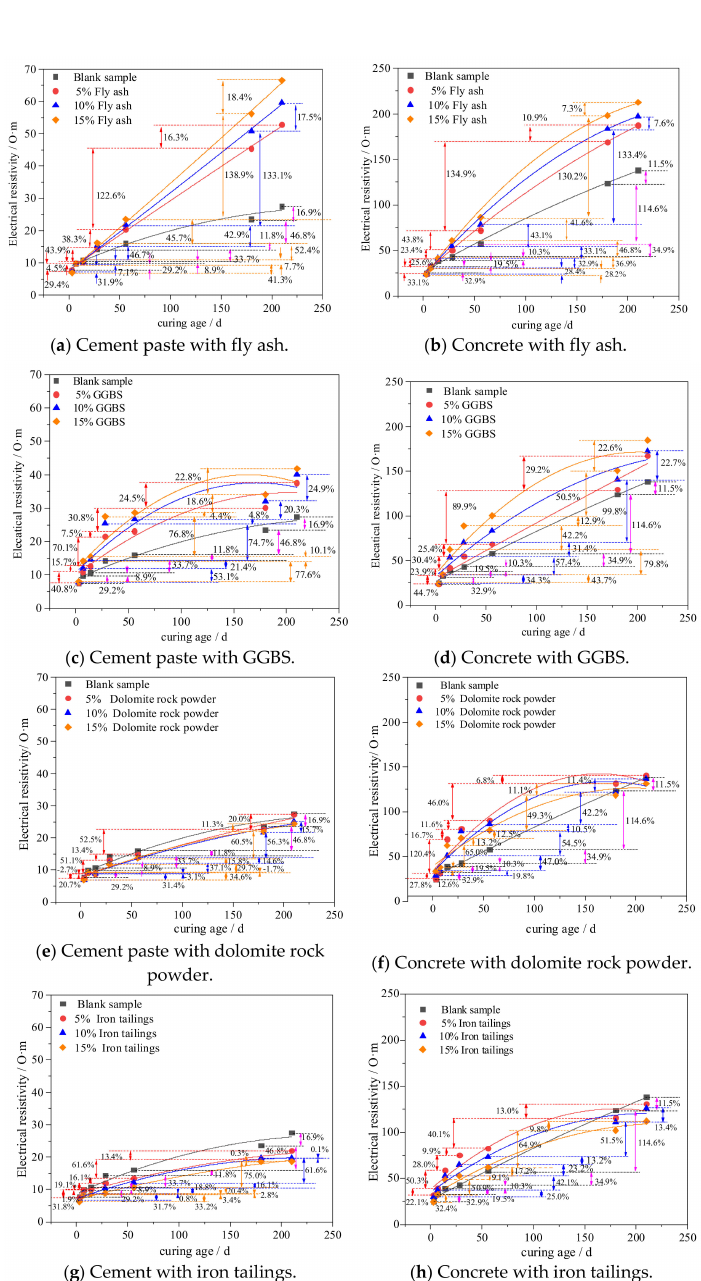
Figure 2. Electrical resistivity of all